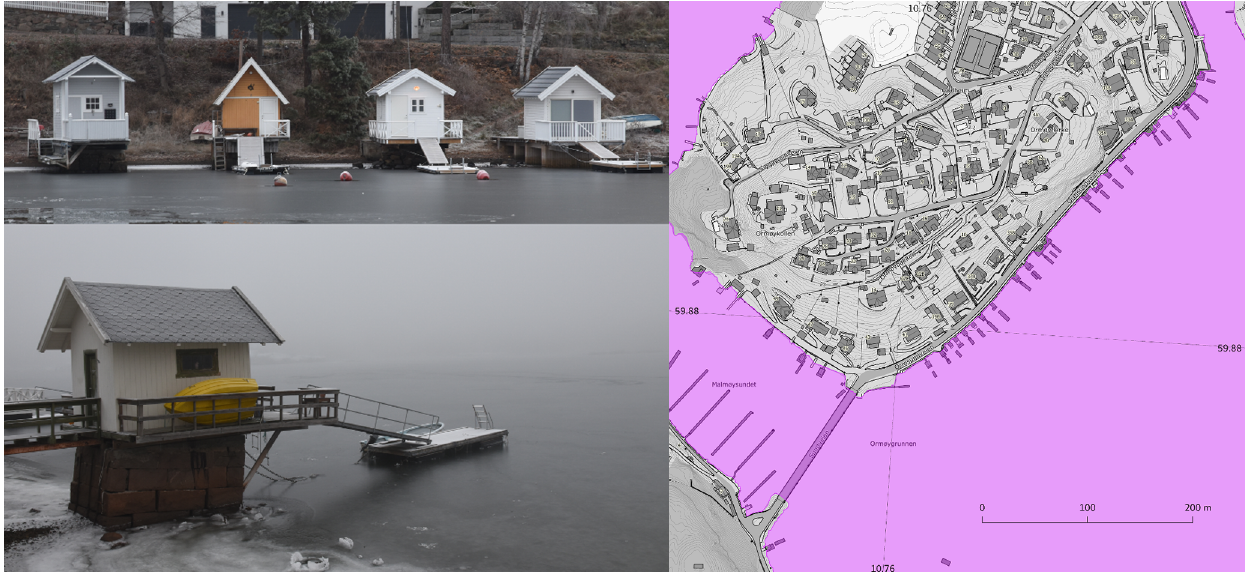
Figure 2. Buildings on piers or pillars above the water surface, like here at Ormøya close to Oslo, are erroneously mapped as flooded for present MHW (violet). Photo: Kristian Breili. Map data shown are provided by Geonorge and Norway Digital consortium and subject to the Norwegian License for Open Government Data (NLOD) 2.0 and Creative Commons BY 4.0 (CC BY